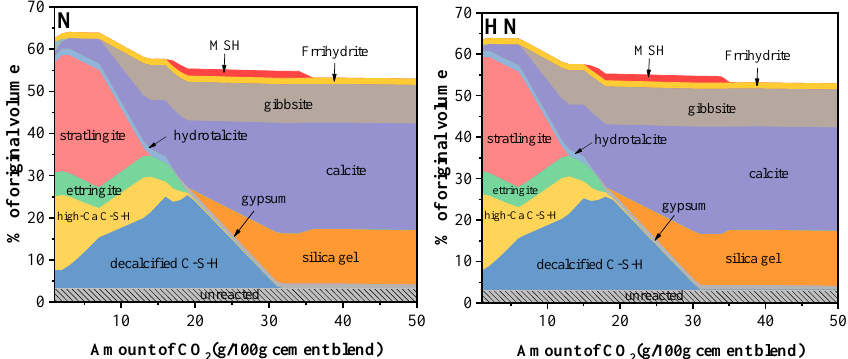
Figure 11. Changes of phase assemblage of N and HN samples.